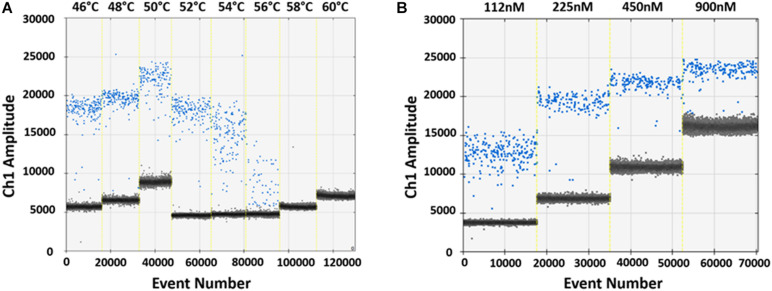
Optimization of ddPCR parameters. (A) Optimization of the GP5+/GP6+ primers annealing temperature using 103 copies/μL pUC19_HPV16 plasmid. Vertical lines represent the gradient of the eight following annealing temperatures: 46, 48, 50, 52, 54, 56, 58, and 60°C. The optimal annealing temperature was 48°C, which resulted in a distinct fluorescence amplitude difference between positive (blue) and negative (gray) droplets. (B) Optimization of the GP5+/GP6+ primers concentration. Optimization was performed using 103 copies/μL pUC19_HPV16 plasmid. Vertical lines represent the different primers concentrations: 112, 225, 450, and 900 nM. The optimal primer concentration resulted 225 nM, based on better amplitude fluorescence spread between positive (blue) and negative (gray) droplets.